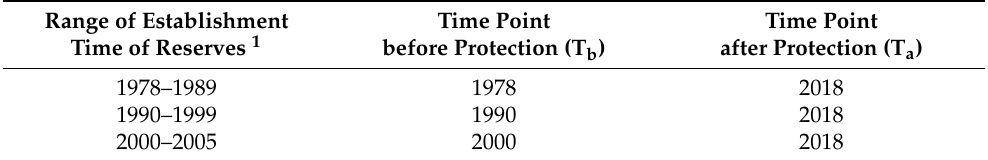
Table 4. Definition of the time point of reserves before and after